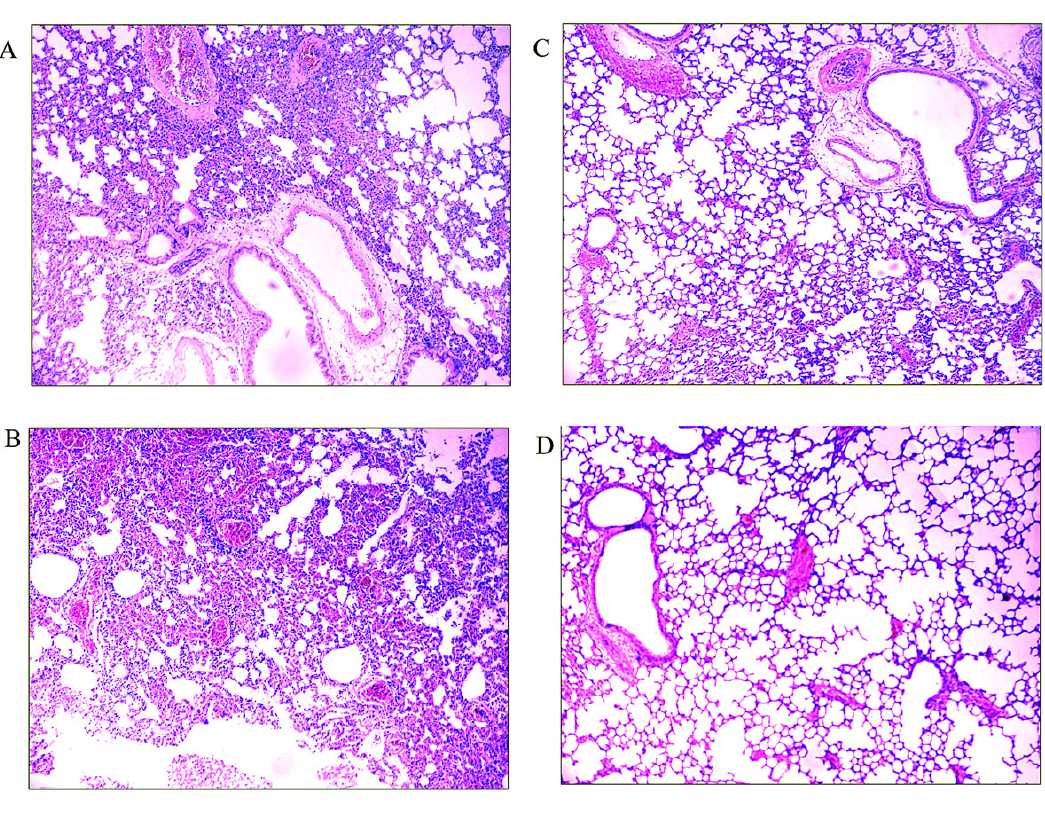
Figure 8: Lung histopathology 24 hours post-challenge. Lung specimens were taken from three mice challenged with A. baumannii in each group and three untreated normal mice at 24 hours post-challenge. Lung tissue sections were stained with haematoxylin-eosin and ob- served under a microscope. (A) Lung tissue from the PBS-treated group. (B) Lung tissue from the adjuvant-treated group. (C) Lung tissue from the rMEP-immunised group. (D) Lung tissue from an unimmunised uninfected normal mouse showing normal histological characteristics. (Magnification: 100×).